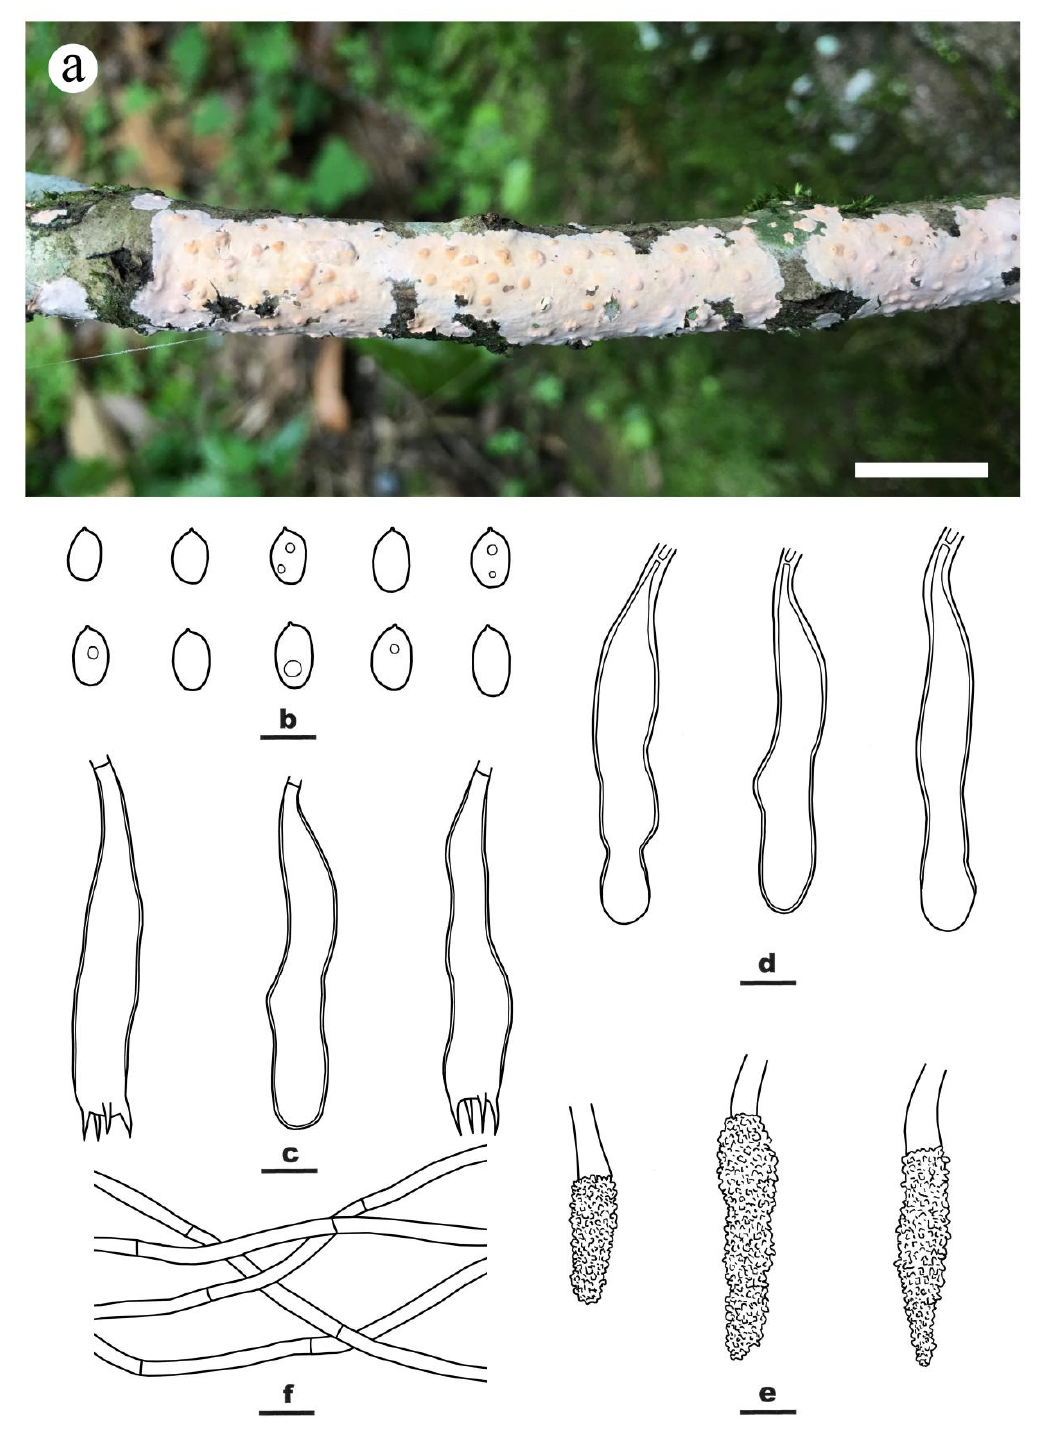
Figure 3. Peniophora cremicolor (( a ) from paratype BJFC 026446; ( b–f ) from the holotype BJFC 026441). Scale bars: ( a ) = 1 cm; ( b – f ) = 10 µm. ( a ). Basidiomes; ( b ). Basidiospores; ( c ). Basidia and a basidiole; ( d ). Gloeocystidia; ( e ). Lamprocystidia; ( f ). Hyphae from subiculum.